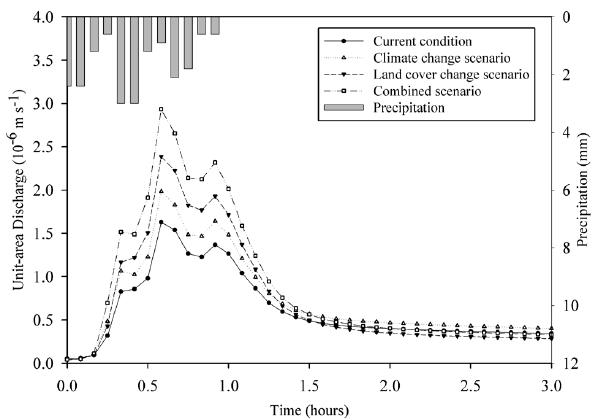
Fig. 4. Precipitation and hydrographs for the current condition, climate change, land cover change and combined climate and land cover change scenarios for WS4.